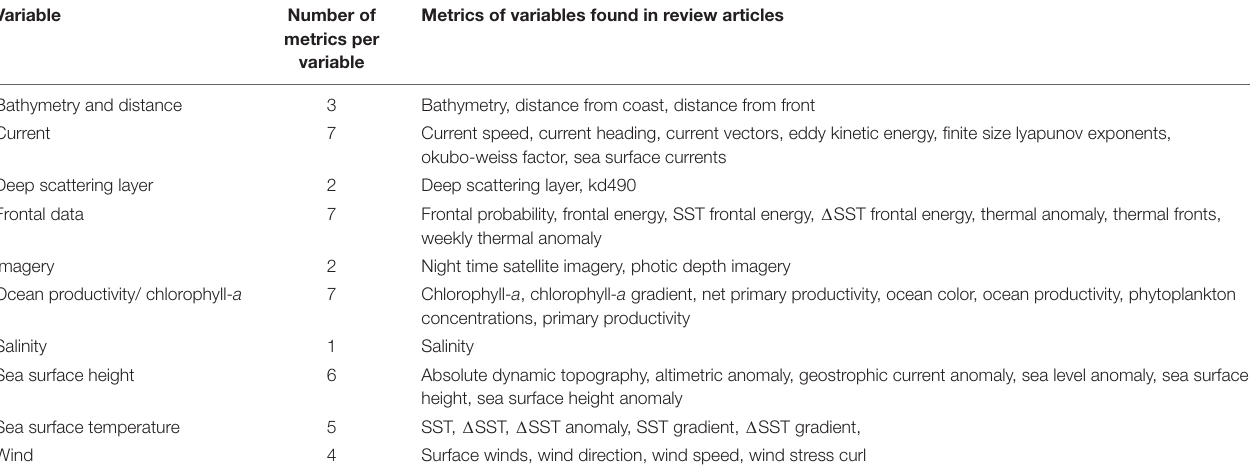
TABLE 1 | Variable categories and reported metrics per variable found across reviewed articles. Variable Number of metrics per